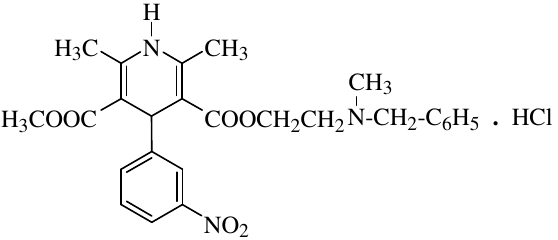
Figure 1 . Structural formula of nicardipine